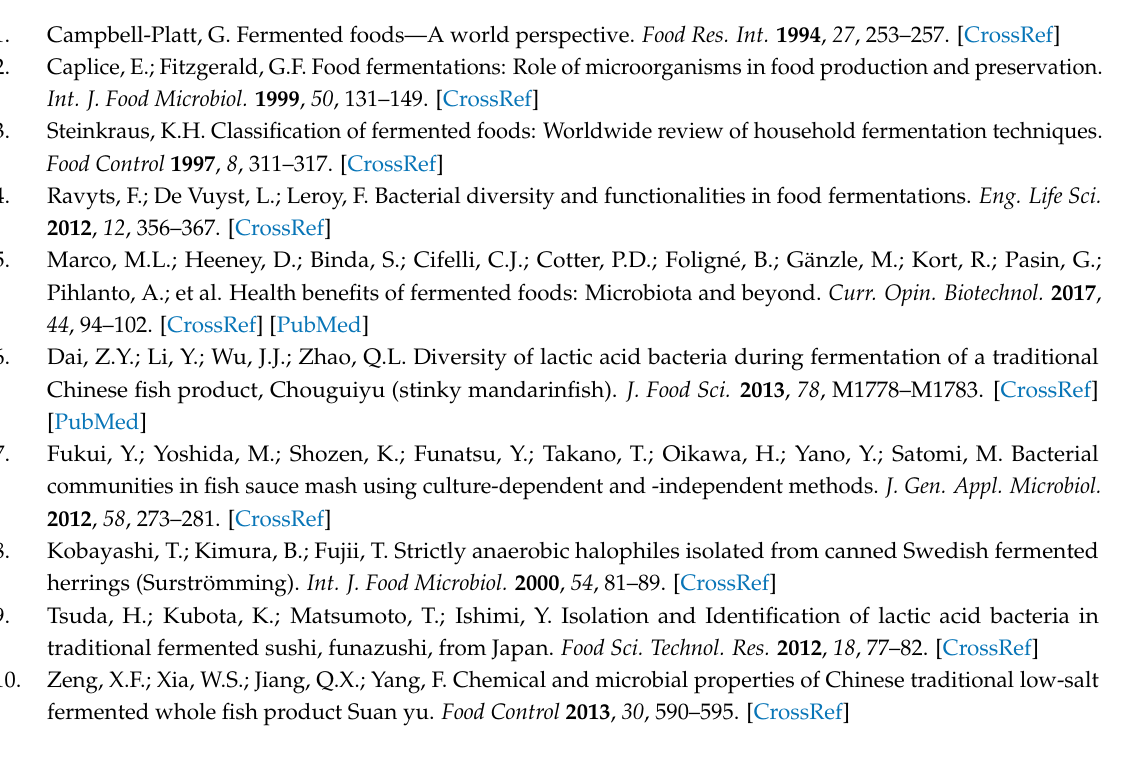
Figure S1: PCoA plot visualizing the weighted UniFrac diversity between samples (MiSeq) collected at day 91 from the three producers: 1; red squared shapes, 2; blue round shapes, 3; green delta shapes. The encircled data points represents samples collected from the second year from Producer 1, Table S1: Classification of the MCR-ALS resolved components using the ribosomal database project (RDP) hierarchical classification. The taxonomic rank with a bootstrap confidence level (given in the brackets) above 80% (in bold typeface) was chosen to represent the corresponding